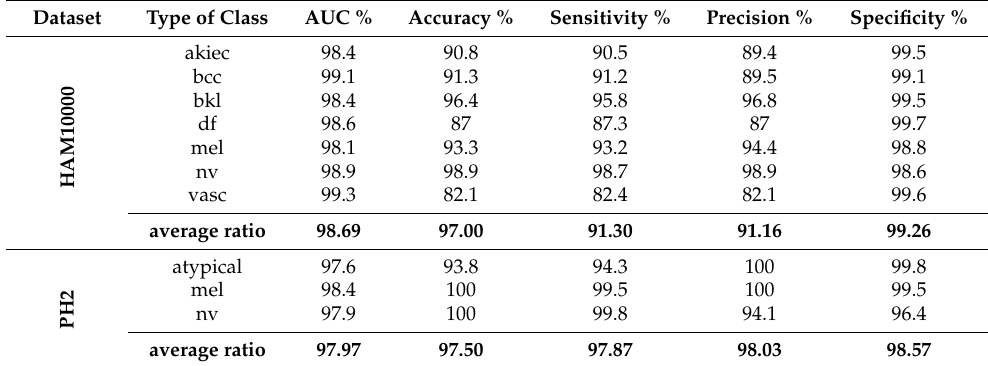
Table 7. Performance of SVM with fused features of MobileNet and ResNet101 for dermoscopic image analysis to classify HAM10000 and PH2 dataset skin lesions.